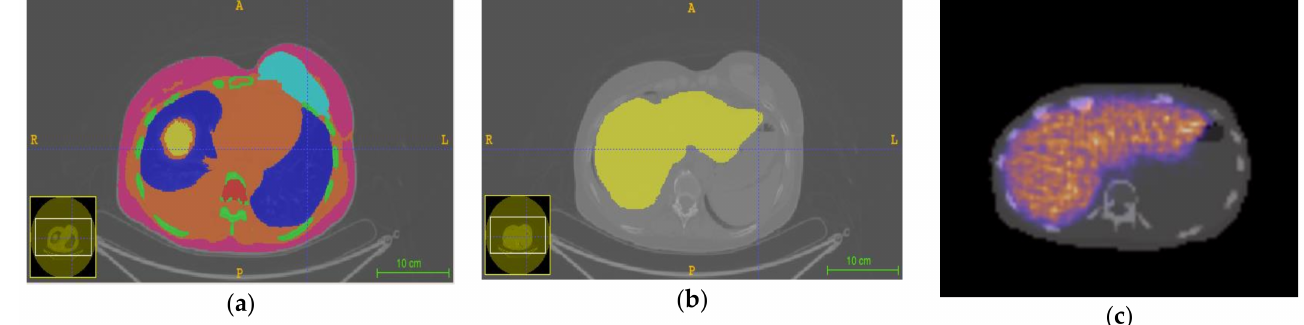
Figure 1. Three transversal slices of different images used in the UL case: ( a ) contoured CT (in this slice all the contoured regions are visible), ( b ) activity map, and ( c ) SPECT superimposed on the coregistered CT.